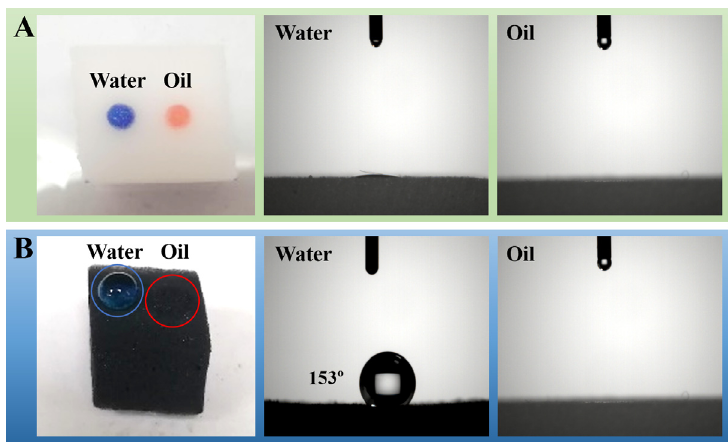
Figure 5. Visual appearance and contact angles of a water/oil droplet on an untreated melamine sponge ( A ) and a m-AS/Kaolin@MS ( B ). The water droplet was colored by methylene blue, and the n-hexane oil droplet was colored by Sudan IV.